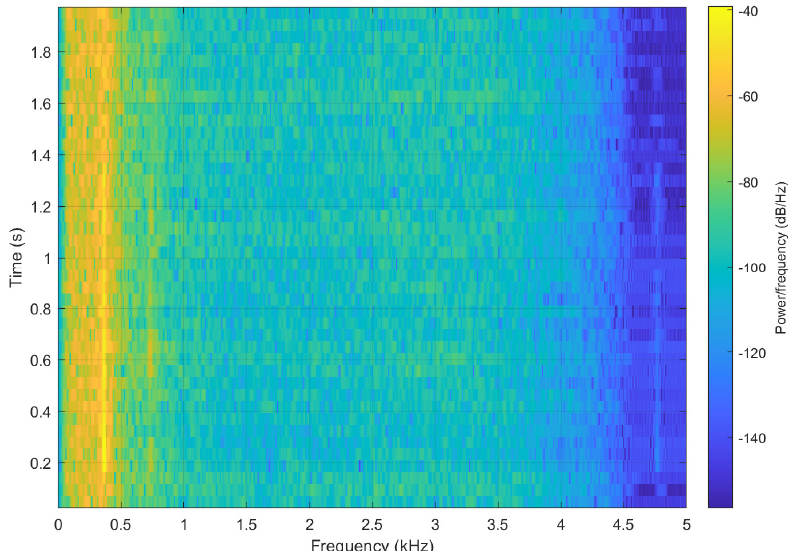
Figure 18. A spectrum of an acoustic phenomena recorded during the 200-m-long dipole antenna flight, possibly related to a nearby airborne lightning